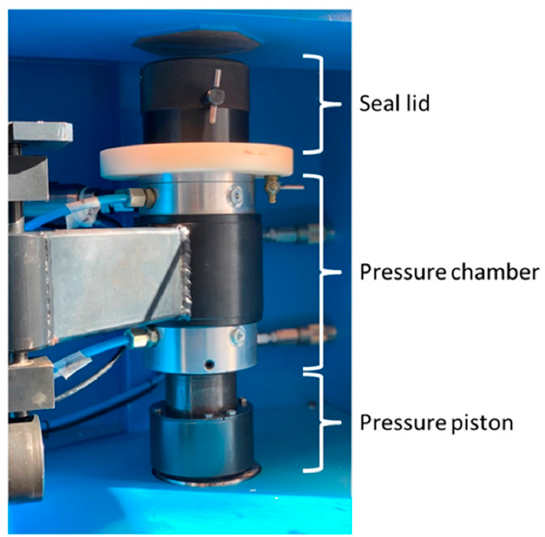
Figure 1. Detail view of the high hydrostatic pressure reactor: Cryo-tubes with cartilage were placed in the pressure chamber.